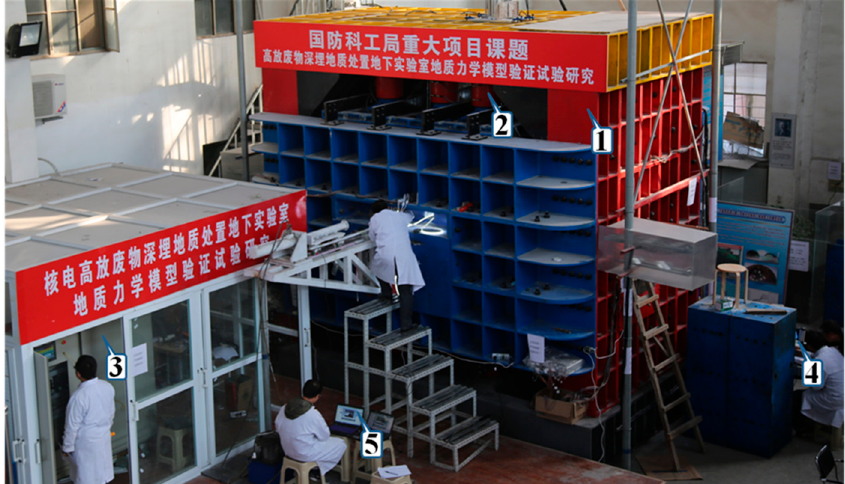
Figure 7. Picture of the model test system after assembly. 1: Combined bench counterforce device; 2: ultrahigh-pressure true 3D non-uniform loading/unloading device; 3: intelligent hydraulic loading/unloading control system; 4: automatic model displacement test system ； and 5: